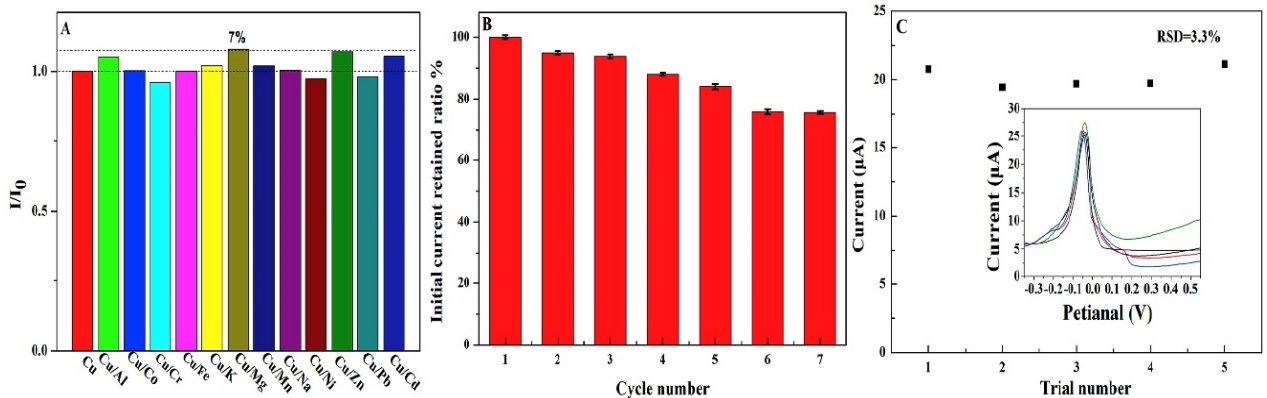
Figure 8. ( A ) Selectivity, ( B ) repeatability and ( C ) reproducibility of chitosan/GO/ion imprinting polymer (CS/GO/IIP) as an electrochemical sensor for Cu ((II) detection (50 µmol/L) [143].